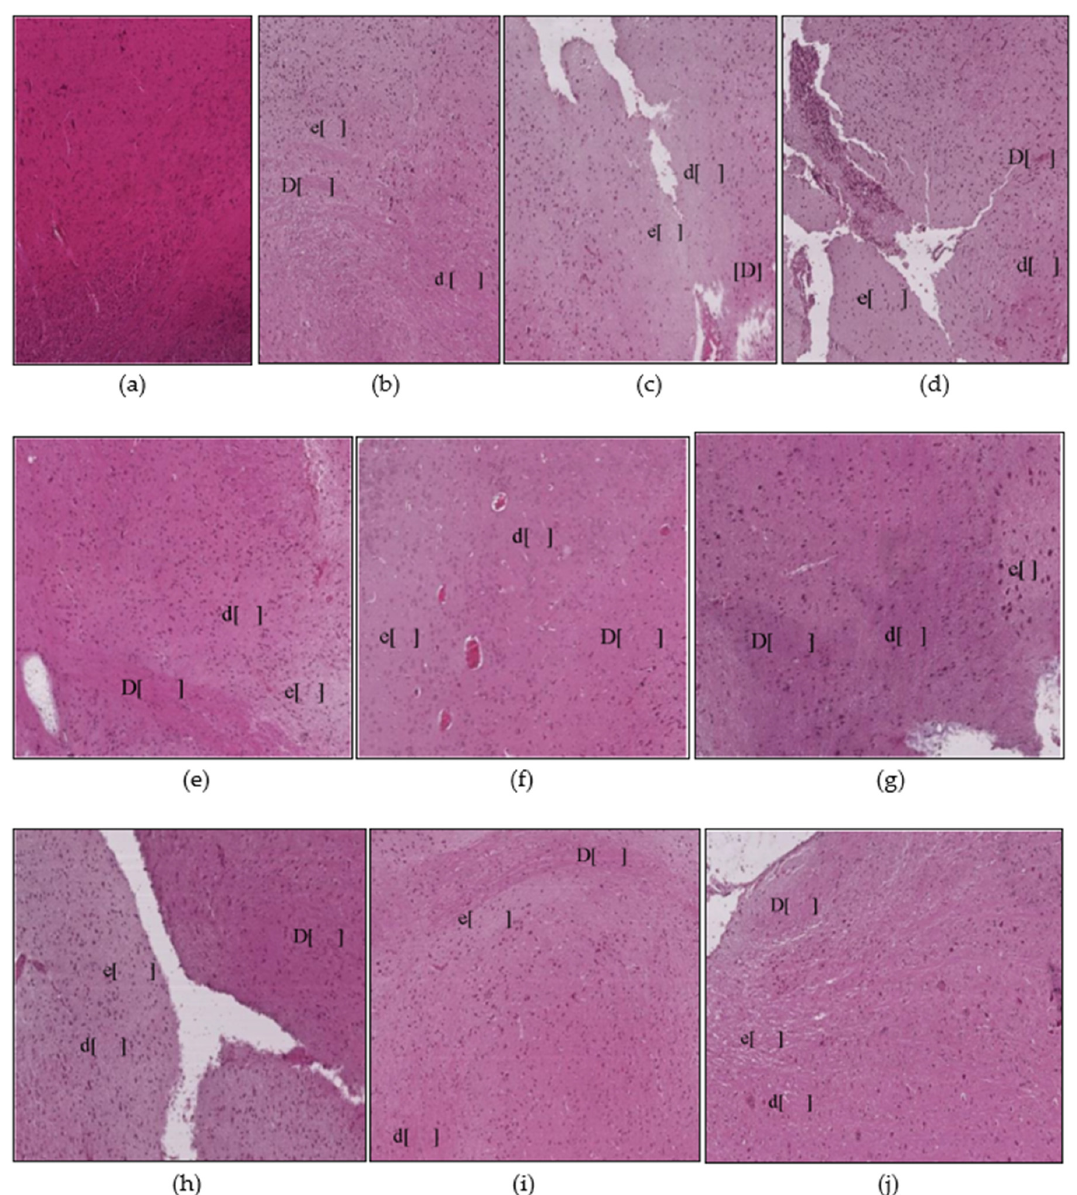
Figure 10. Histopathological photomicrographs (H&E, 400×) of brain tissues showing control ( a ), and the changes after exposure to mosquito repellant ( b – d , Mat-based vapor, Liquid formulation vapor, and Burning-coil-based smoke groups, respectively), and supplementations of pyrethroid-exposed animals with ascorbic acid ( e – g , Mat-based vapor and AA, Liquid formulation vapor and AA, and Burning-coil-based smoke and AA groups, respectively), or E307 ( h – j , Mat-based vapor and E307, Liquid formulation vapor and E307, and Burning-coil-based smoke and E307 groups, respectively). Abbreviations in the figures with parentheses represent nervous tissue degeneration (D), decreased number of neurons (d), and decreased uptake of eosin (e).